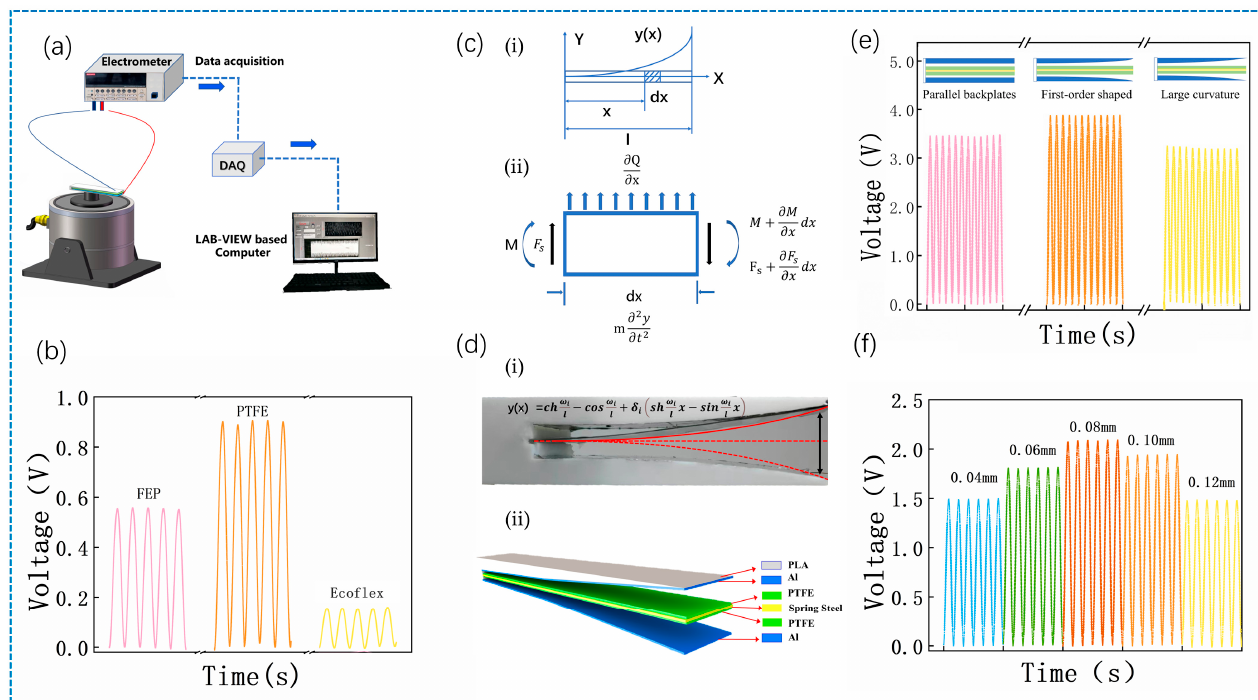
Figure 2. Structure optimization of the LV-TENG. ( a ) Test system; ( b ) Effect of electronegative materials on the electrical output of the LV-TENG; ( c ) Model simplification and force analysis of cantilever beam; ( d ) Dynamic vibration profile of the cantilever beam and the schematic diagram of the Al electrodes; ( e ) Effect of electrode structure on the output of the LV-TENG; ( f ) Effect of cantilever beam thickness on the output of the LV-TENG.